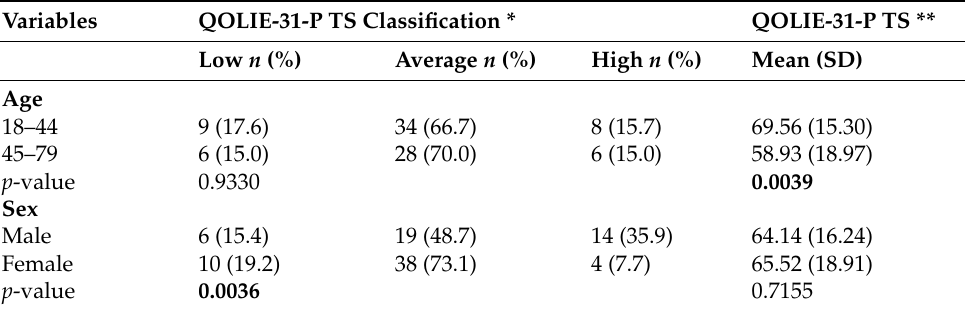
Table 1. Socio-demographic and clinical characteristics of participants and QOLIE-31-P TS.